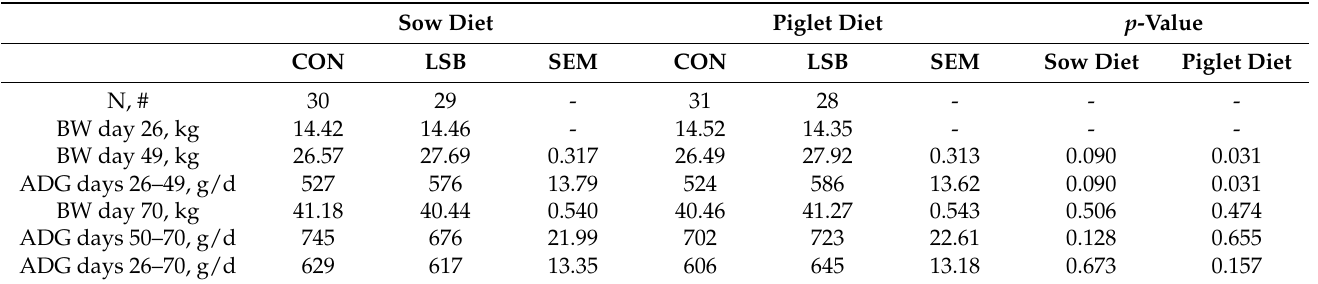
Table 5. Performance results of sampled pigs by sow diet and piglet